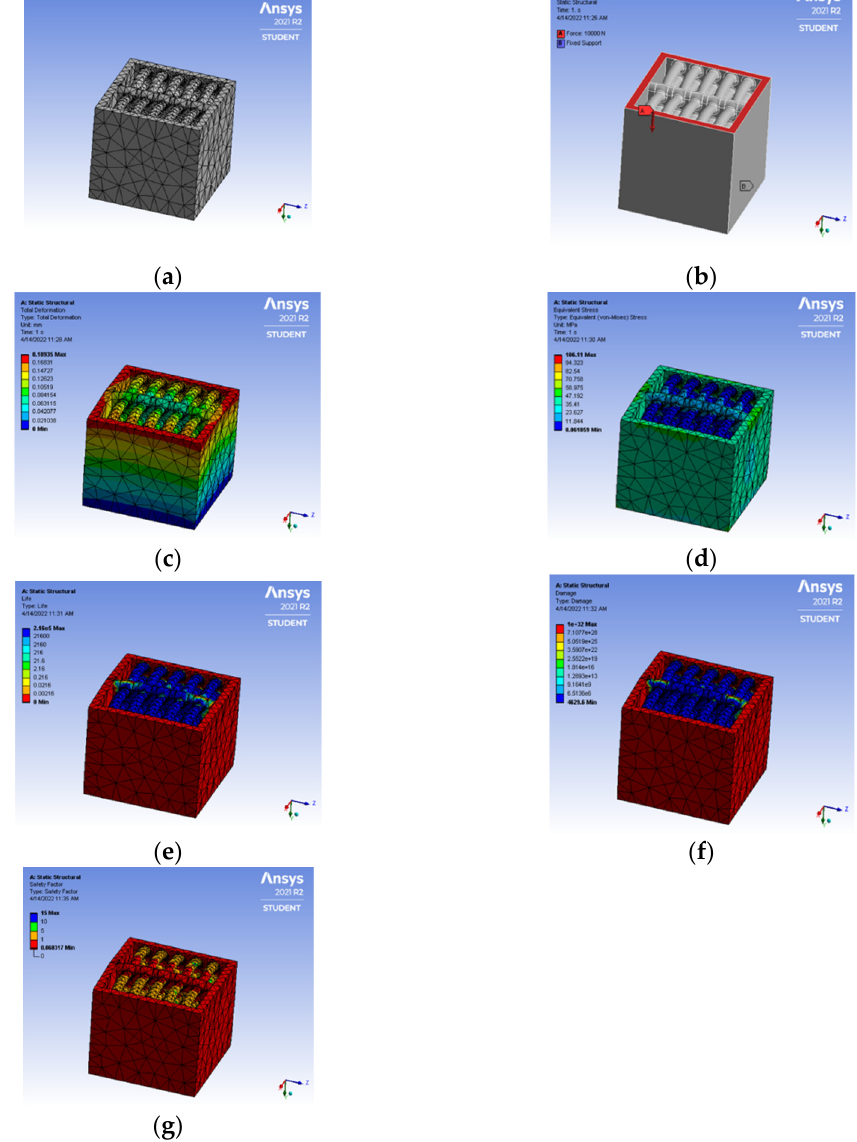
Figure 17. ( a ) Mesh generation; ( b ) Loads and boundary conditions; ( c ) Total deformation; ( d ) Von mises stress; ( e ) Life cycle; ( f ) Damage; ( g ) Factor of safety.